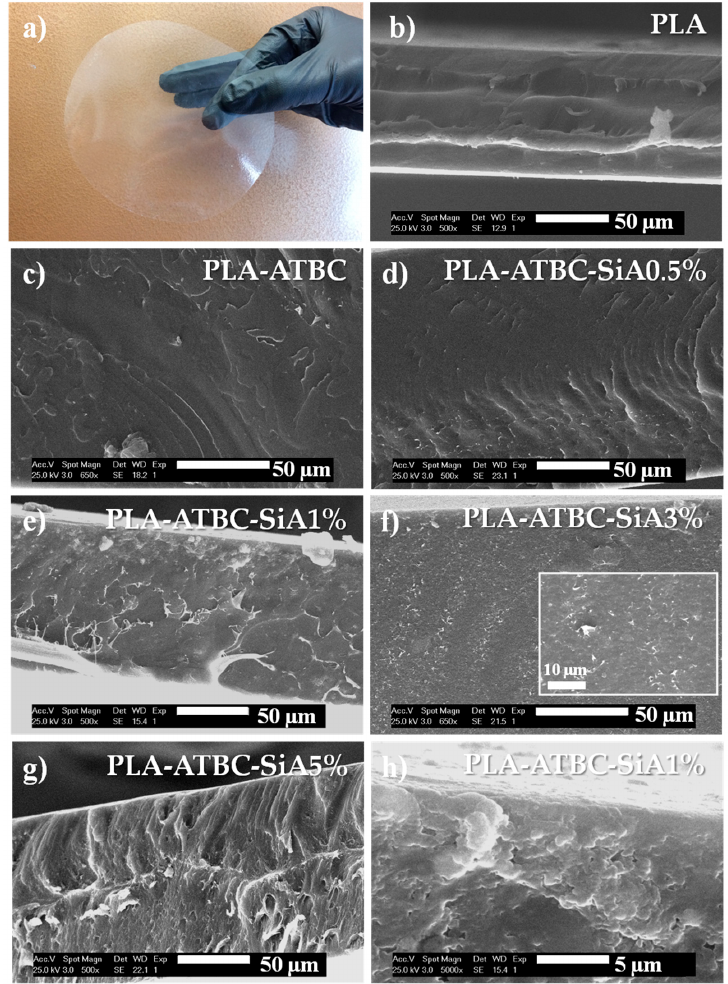
Figure 1. ( a ) Visual appearance of PLA-ATBC-SiA3% composite film. Cryo-fractured SEM micrographs of: ( b ) PLA, ( c ) PLA-ATBC, ( d ) PLA-ATBC-SiA0.5% aerogel, ( e ) PLA-ATBC-SiA1%, ( f ) PLA-ATBC-SiA3% (zoom image at 2000 × ), ( g ) PLA-ATBC-SiA5%, and ( h ) PLA-ATBC-SiA1% at higher magnification (5000 ×